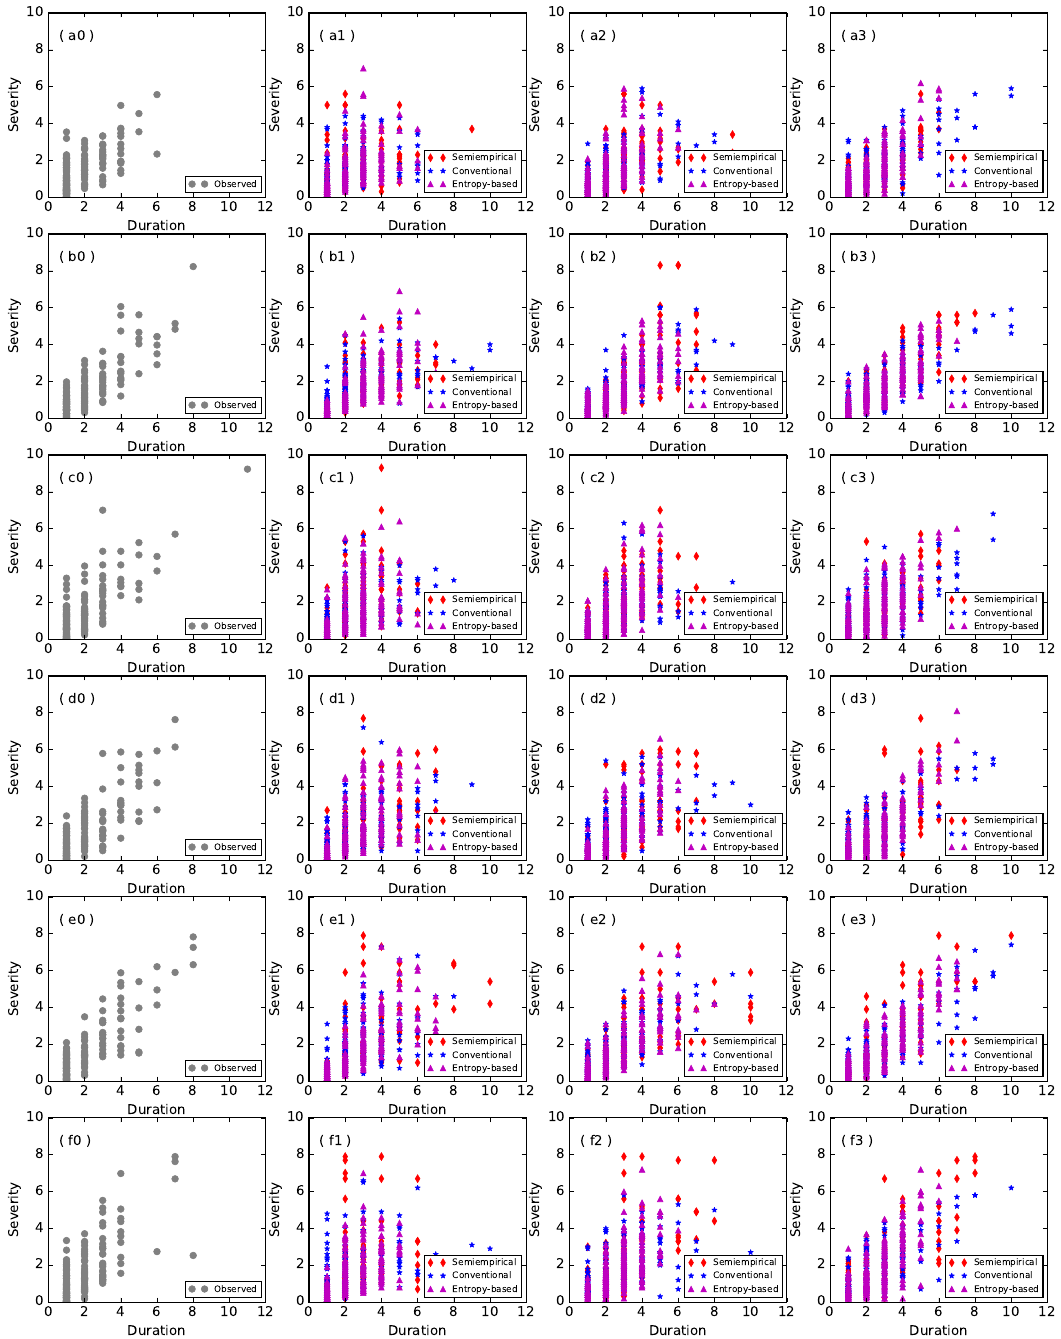
Figure 8. Copula based joint distribution for six stations: ( a0 – f0 ) Observed; ( a1 – f1 ) Claython; ( a2 – f2 ) Frank; ( a3 – f3 ) Gumbel; ( a – f ) as in Figure